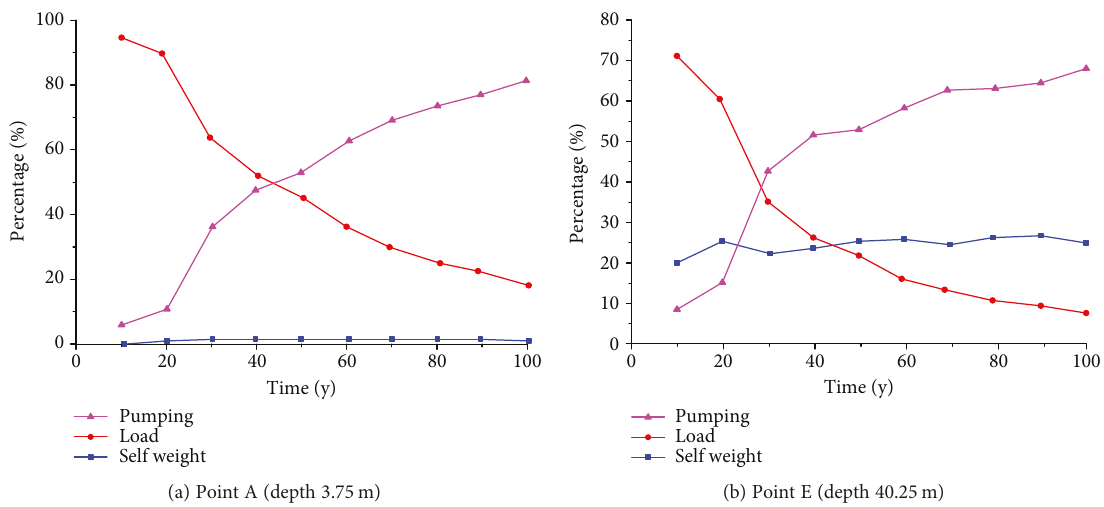
Figure 18: Percentage of settlement caused by di ff erent reasons when loading intensity is 10 kPa.